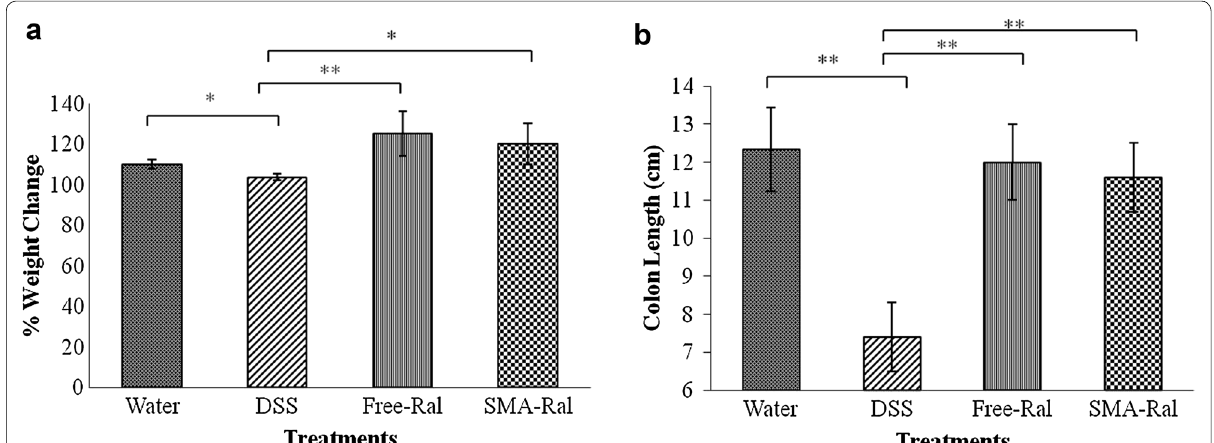
Fig. 4 a Effect of free and SMA Ral treatments compared to DSS on mouse weight. The average weight change for each cage was calculated relative to the first day. b Results of colon length measurements in the differently treated mouse groups. All data are expressed as mean * denotes p 0.05 and ** denotes p 0.001 as determined by t ≤ ≤